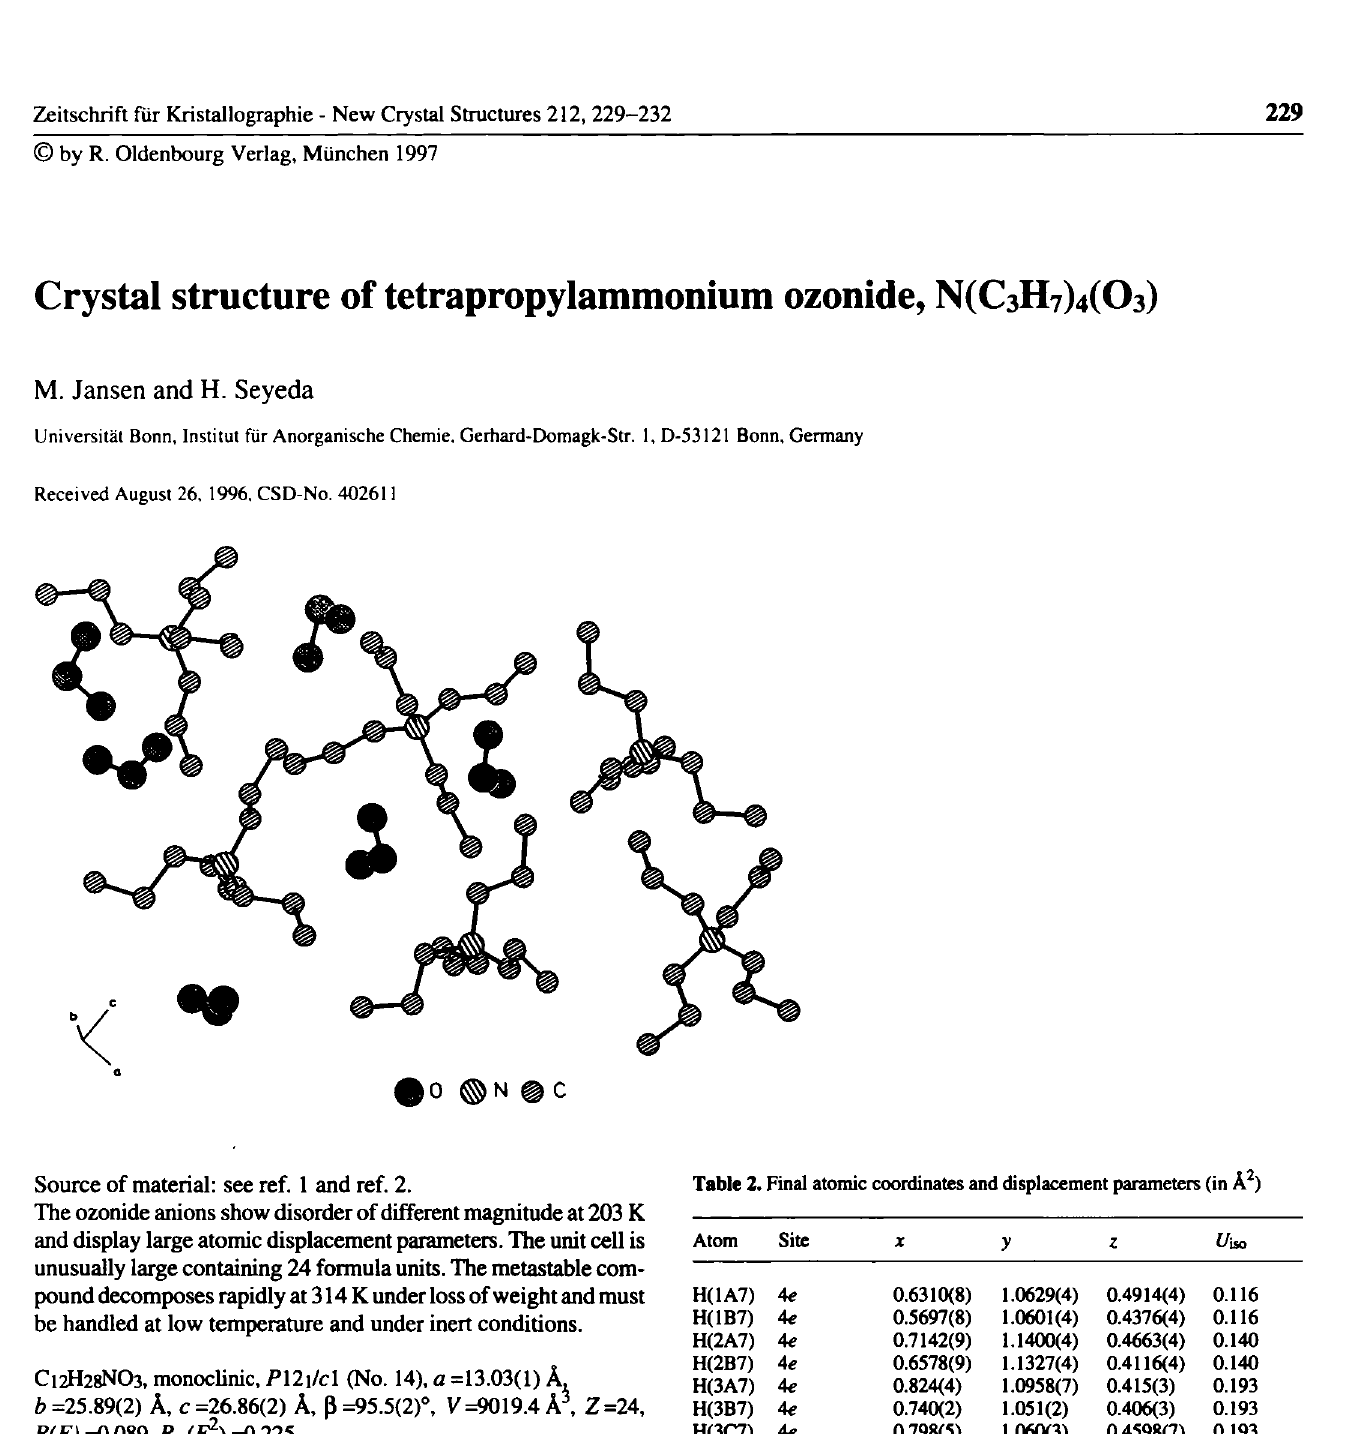
Table 1. Parameters used for the X-ray data collection Crystal: